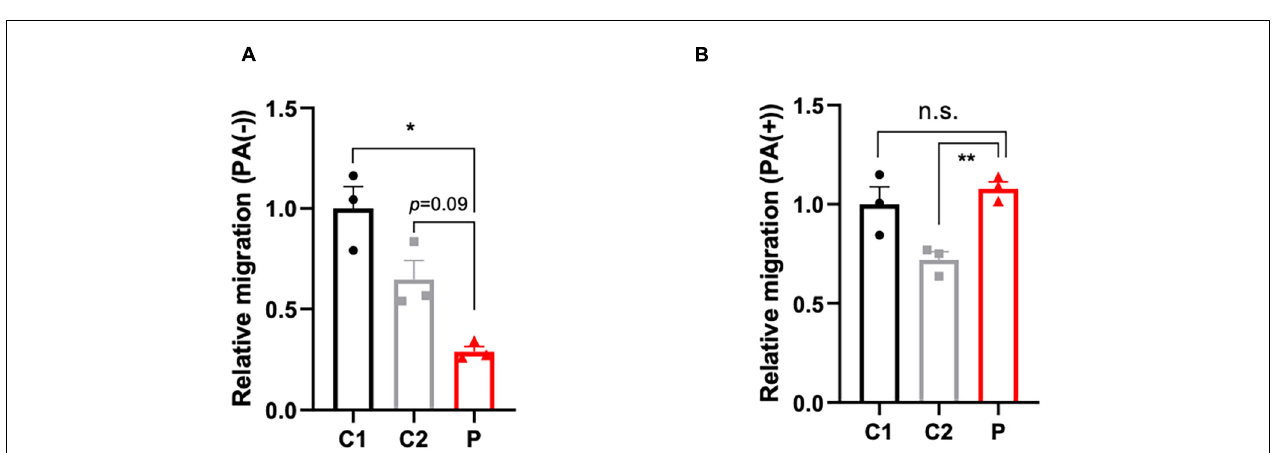
FIGURE 3 | Migration capacity of lymphocytes with or without palmitate supplement. (A) Relative migration of patient- and control-derived lymphocytes without palmitate supplement and (B) with palmitate. One-way ANOVA applied in panels (A,B) . * p < 0.05, ** p < 0.001.